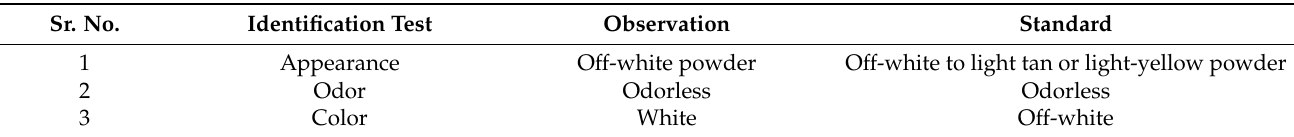
Table 2. Organoleptic properties of PRX.